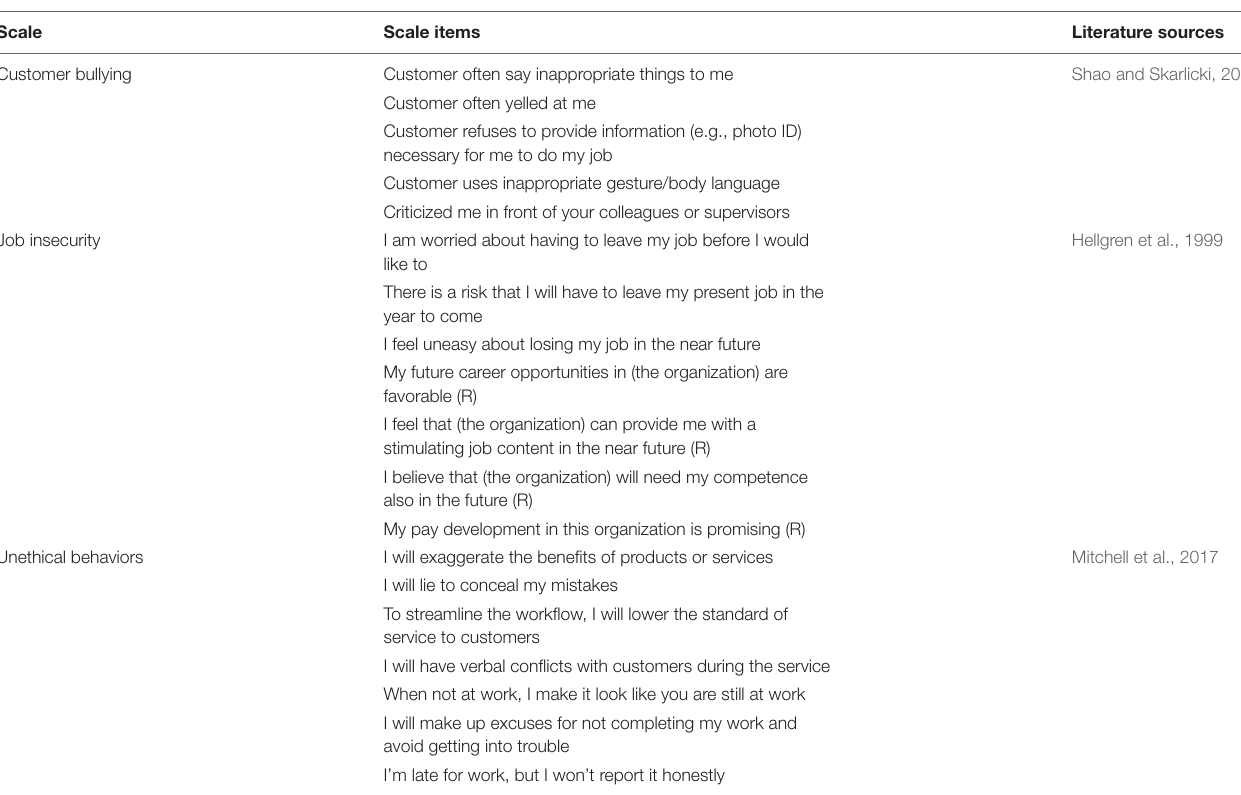
TABLE 2 | Summary of scale items for this